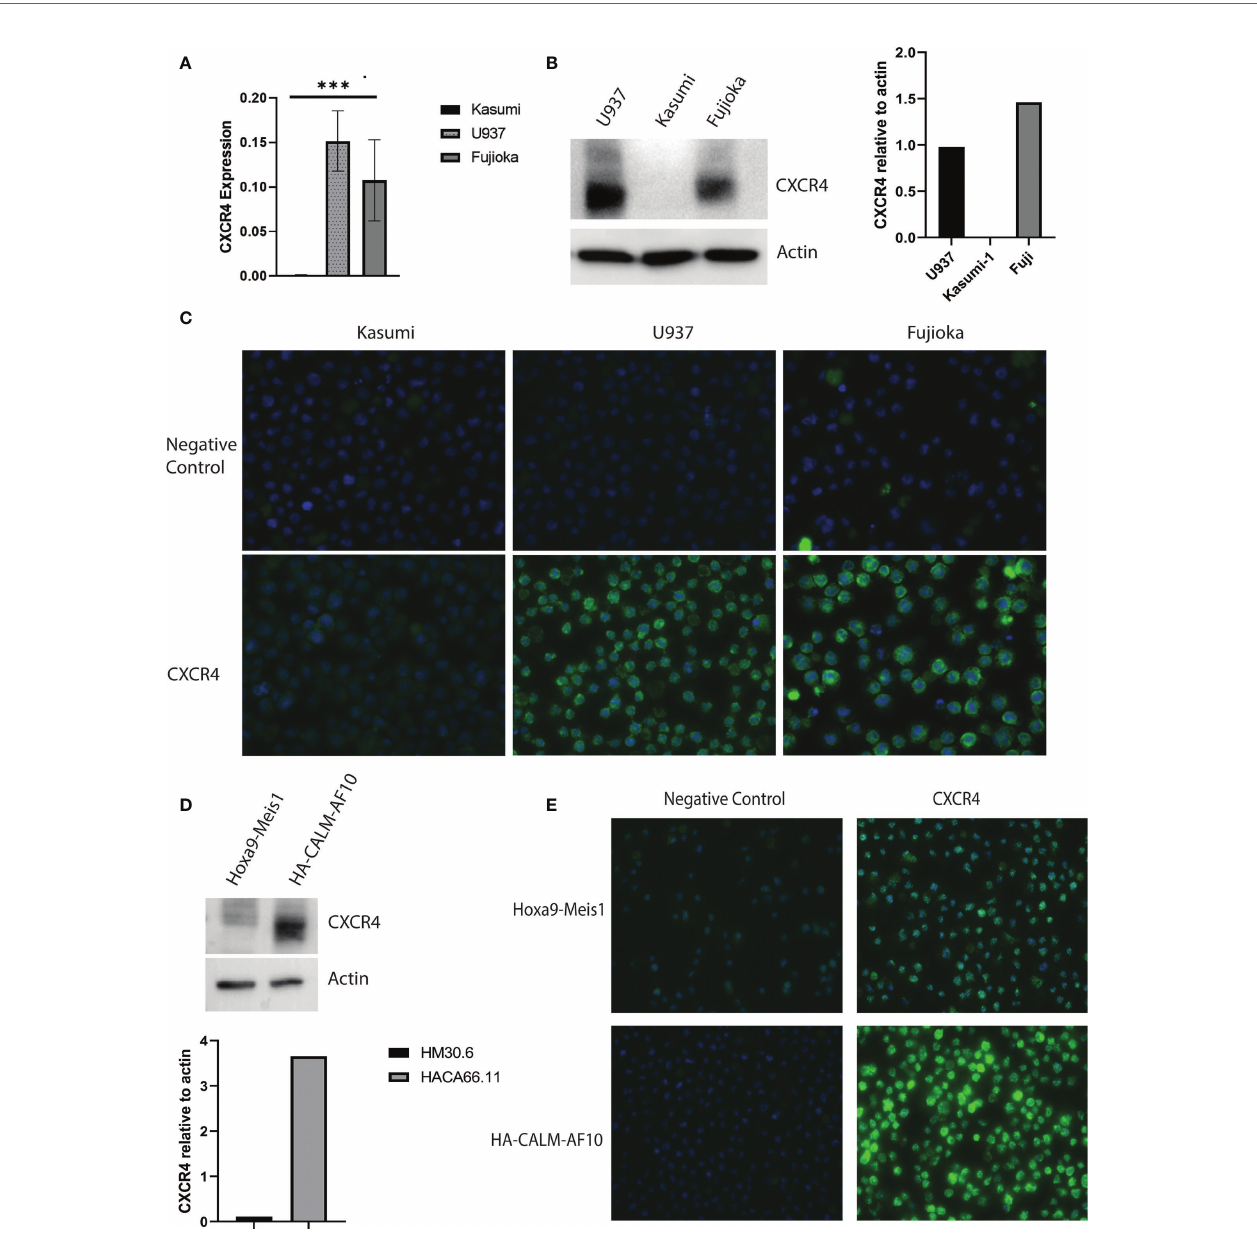
FIGURE 2 | Increased CXCR4 expression in CALM-AF10 transformed leukemia cells. CXCR4 expression is evaluated in human myeloid leukemia cell lines characterized by the CALM-AF10 translocation (U937 and Fujioka) and compared with a myeloid leukemia cell line not containing the CALM-AF10 translocation. Expression is examined by transcript quanti fi cation, with values shown relative to GAPDH (A) , and protein evaluation by Western blot, with corresponding densitometry normalized to actin (B) . Immuno fl uorescence staining of human leukemia cells reveals increased CXCR4 expression is concentrated on the plasma membrane (C) . (D) High CXCR4 protein expression is con fi rmed by Western blot in a murine leukemia induced by CALM-AF10 , compared with a murine leukemia characterized by the Hoxa9-Meis 1 translocation, with corresponding densitometry shown, normalized to actin. (E) Immuno fl uorescence staining in the CALM-AF10 translocated murine leukemia cells reveals increased CXCR4 expression is concentrated on the plasma membrane. ***p <